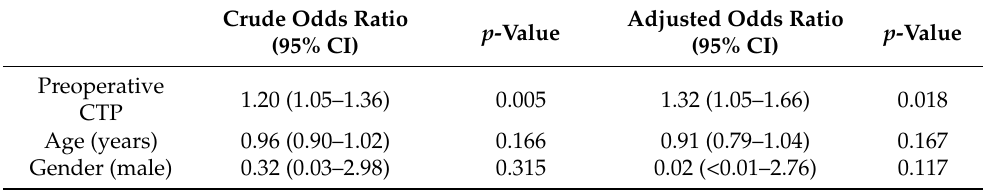
Table 4. Odds ratio of fast recovery group assignment in relation to baseline variables. Crude Odds